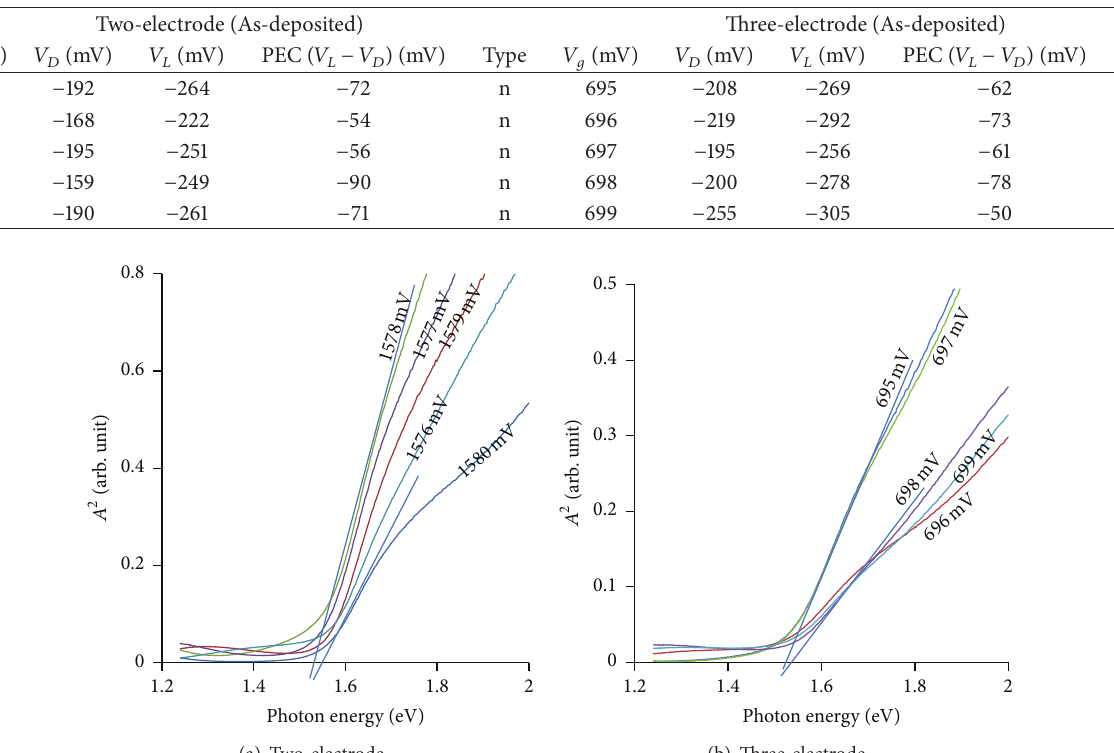
Figure 4: Square of absorbance ( 𝐴 2 ) versus photon energy for as-deposited CdTe samples grown with (a) two-electrode system and (b) three-electrode system for 1 hour at different cathodic